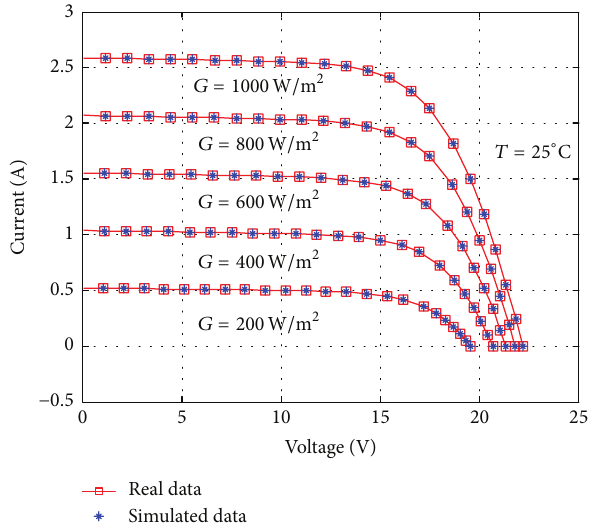
Figure 9: Comparison between real data and the simulated data by PCE for multicrystalline KC200GT at different temperatures.